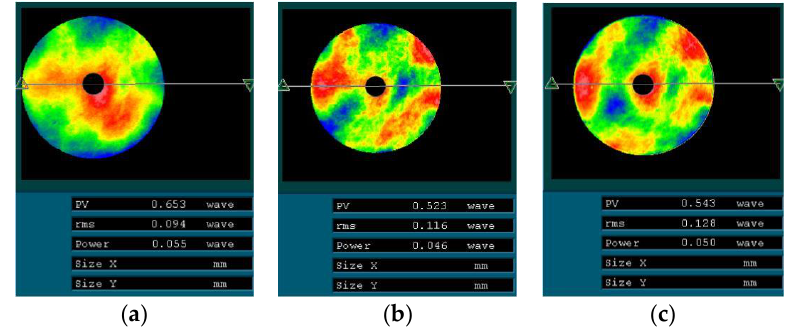
Figure 17. Detection results for each field of view after adjustment. ( a ) F (0,0), 0.094 𝜆 ( b ) F (0,−0.1), 0.116 𝜆 and ( c ) F (0,0.1) 0.128 𝜆 .